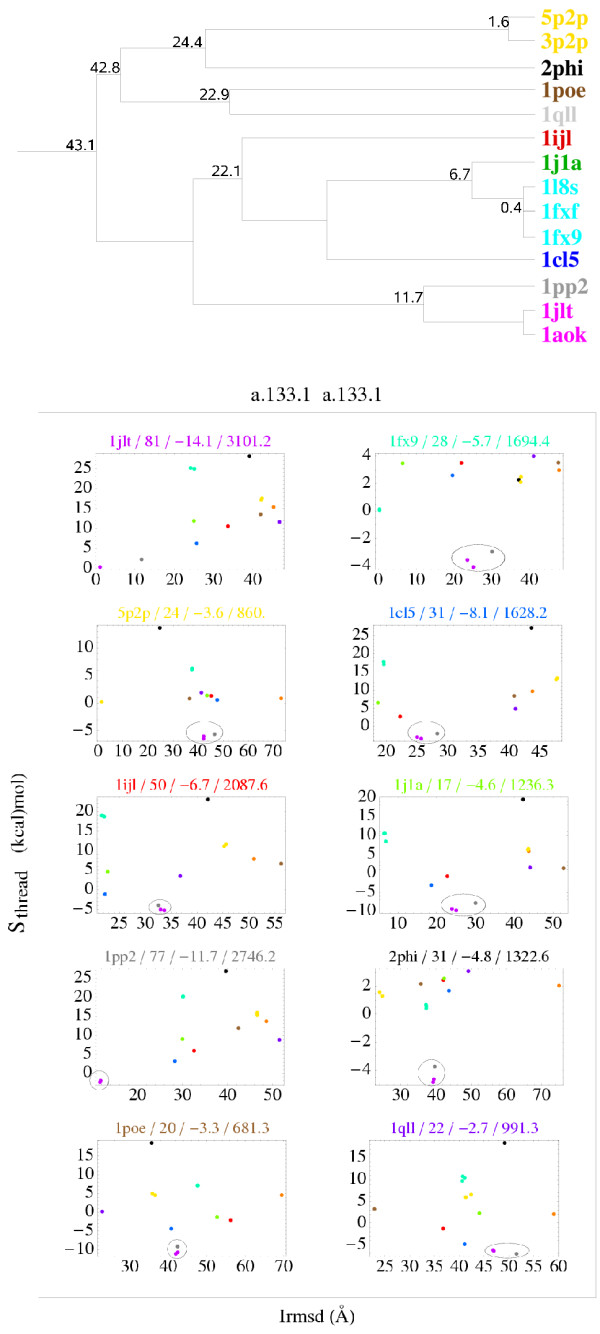
a.133.1 group: representation of binding modes. Same view as in Fig. 3. The largest discrimination failures in each panel are circled. They all correspond to sequences threaded onto the same model structures: 1JLT, 1AOK, and 1PP2, which have especially large interfaces (see text and panel headers).